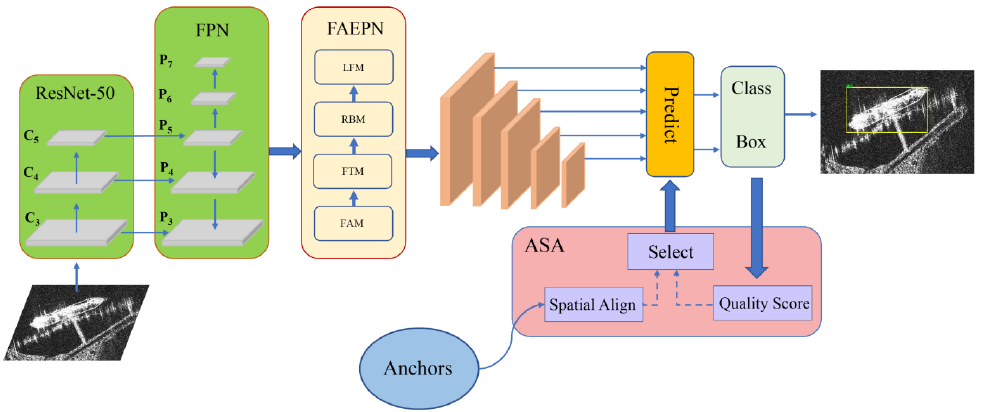
Figure 3. The overall structure of our